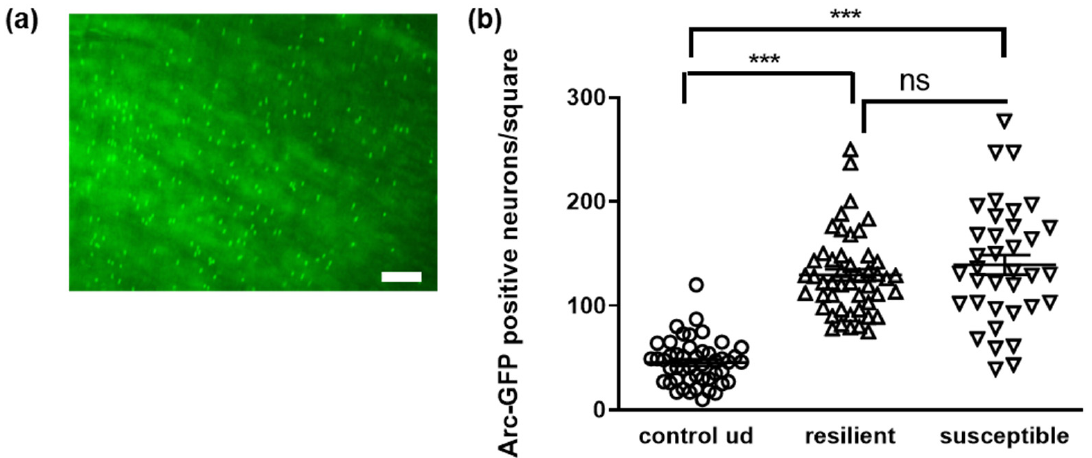
Figure 4. Activation of enteric neurons during social interaction testing after chronic social defeat treatment. Male Arc-sfGFP mice were treated as described for C57BL6/J mice (see Figure 1a). Tamoxifen was injected 5 h before social interaction to label activated neurons [26]. ( a ) Arc-expressing, activated neurons were visualized by their GFP signal under the fluorescent microscope in LMMPs from the ileum of defeated and undefeated control mice. Scale bar: 100 µ m. ( b ) Stained cells were counted from a defined area for each animal (see also Supplementary Figure S1). Statistical analysis was conducted by one-way ANOVA (Tukey’s multiple comparison test; *** p < 0.001, n = 48 for undefeated and 48/36 for defeated animals, derived from four (control/resilient) and three (susceptible) mice per group).